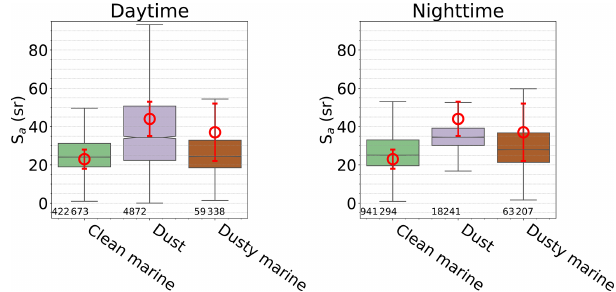
Figure 9. CALIPSO–SODA lidar ratios at 5km horizontal resolu- tion for the three most abundant aerosol types: clean marine, dust, and dusty marine. Symbols and legends as in Figs. 7 and